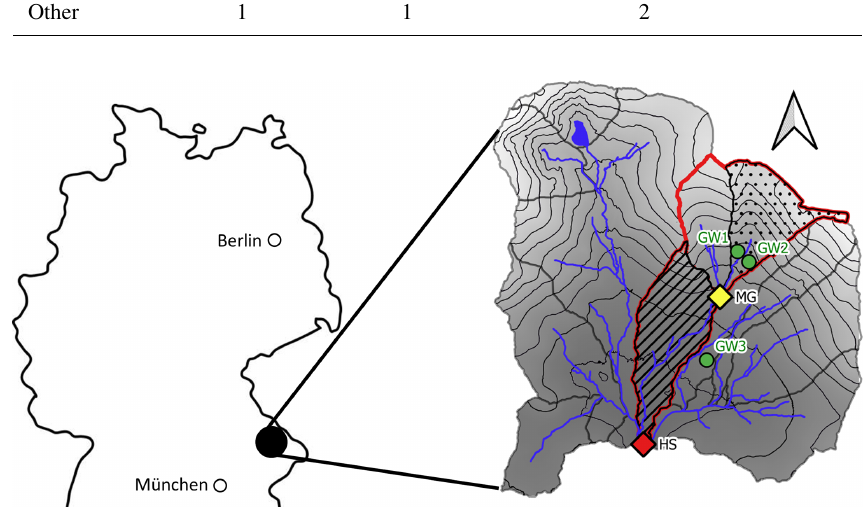
Figure 1. The Große Ohe catchment is located in southeastern Germany (left-hand side). The high-frequency sampling sites were located at the outlet of Hinterer Schachtenbach (red diamond) and Markungsgraben (yellow diamond). The red outline shows the total area contribut- ing to the outlet of Hinterer Schachtenbach, including the subcatchment Markungsgraben (dotted), Hinterer Schachtenbach (hatched) and Kaltenbrunner Seige (no pattern). The deep groundwater wells (green dots) were located in the subcatchment Markungsgraben and in the riparian zone of a neighboring subcatchment. Stream channels were identified using a 5m resolution digital elevation model (DEM). Both the location of the stream channels and the DEM were provided by the Bavarian State Office for Environment.